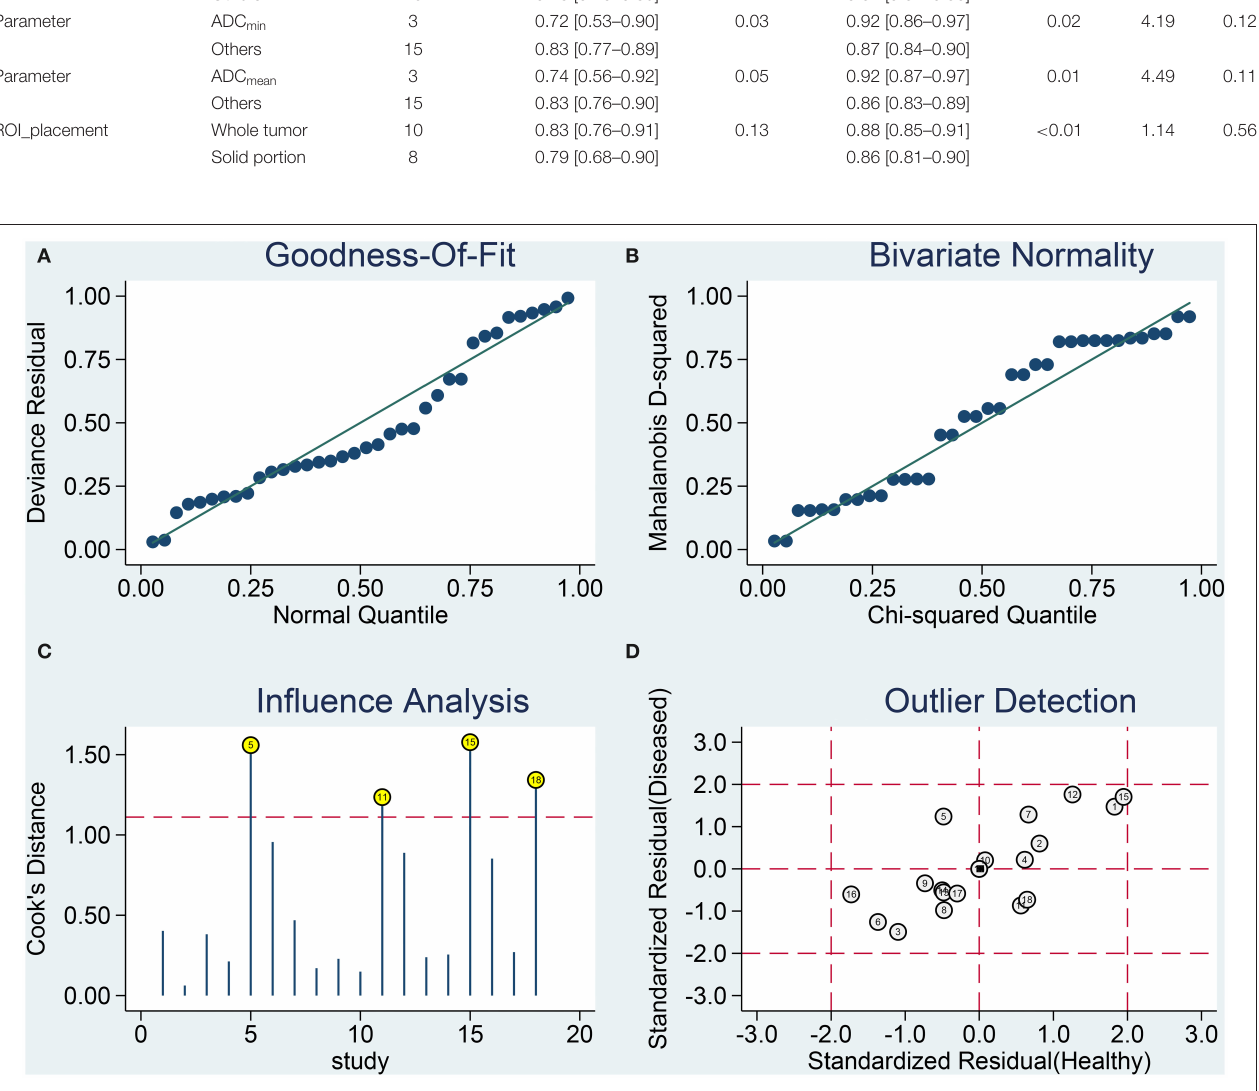
FIGURE 6 | Results from sensitivity analysis. (A) Goodness-of-fit, (B) bivariate normality, (C) influence analysis, and (D) outlier detection.